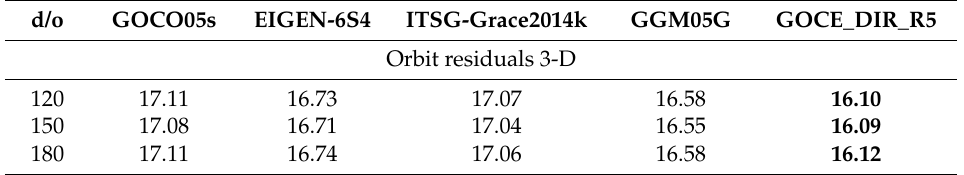
Table 4. GRACE-A orbit residuals based on dynamic orbit determination. The results are expressed by RMS in cm.